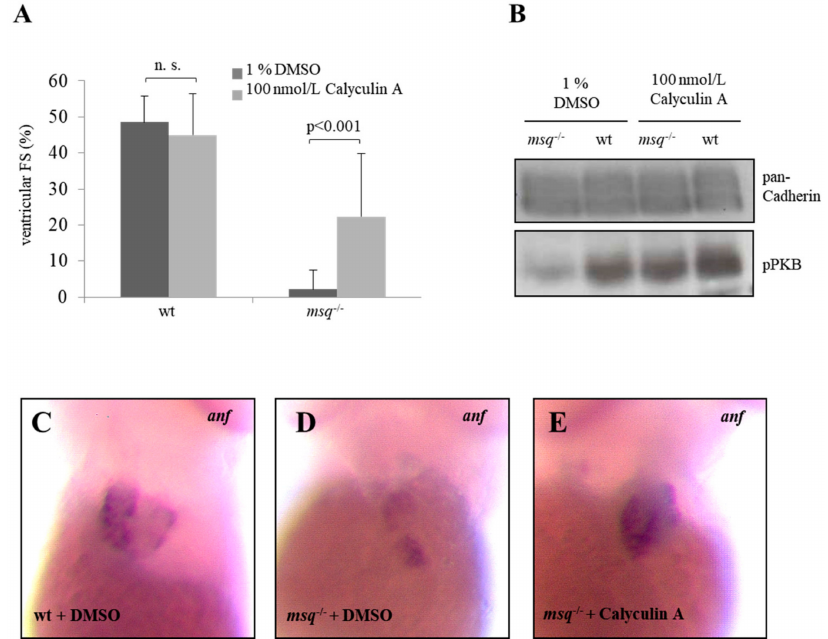
Figure 4. Calyculin A reconstitutes contractile force, PKB phosphorylation and anf expression in msq . ( A ) Ventricular FS of homozygous mutant msq embryos ( msq − / − ) in comparison to wild-type (WT) zebrafish. Homozygous msq embryos treated with 100 nmol/L calyculin A during 4–96 hpf displayed improved contractile force (25.4 ± 18.9% ( p = 0.00015) compared to embryos incubated with DMSO (2.2 ± 5.3%). (n.s.: Not significant) ( B ) Treatment of homozygous msq − / − embryos with 100 nmol/L calyculin A displayed an increased PKB phosphorylation (pPKB) in comparison to controls. In situ hybridization revealed that calyculin A treated homozygous msq − / − embryos ( E ) show, in contrast to DMSO-treated wild-type zebrafish ( C ) and DMSO-treated msq − / − embryos ( D